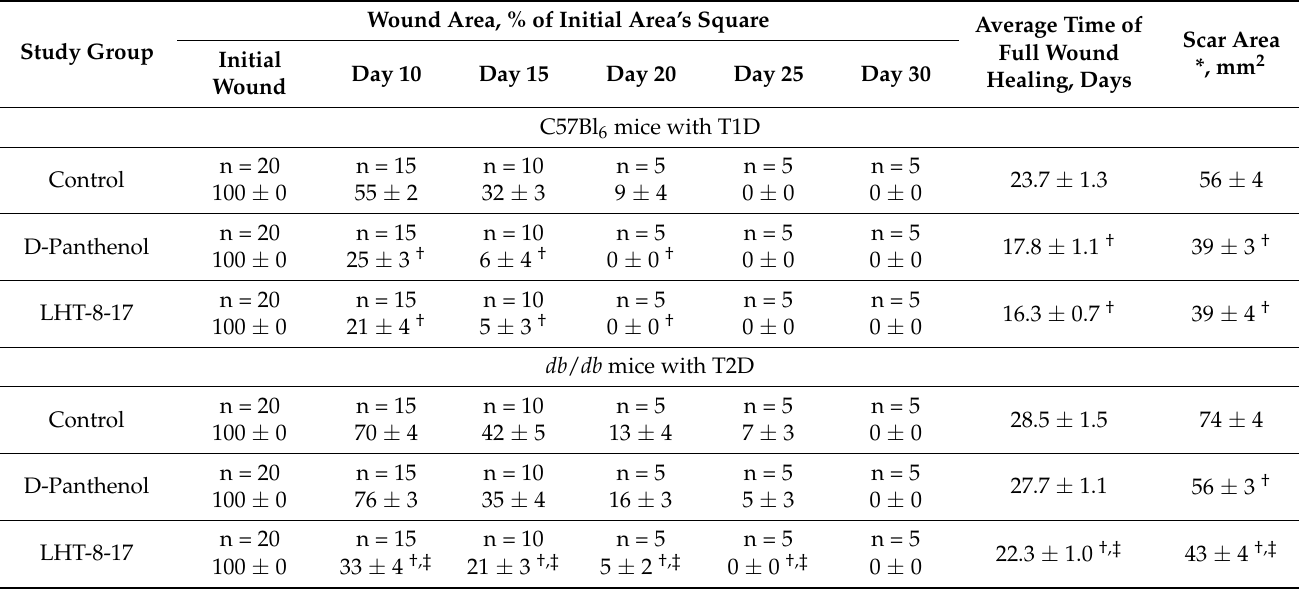
Table 1. The dynamics of non-infected wound areas (% of initial area’s square) in streptozotocin-induced (T1D) and db/db (T2D) mice, topically treated with 4 mg LHT-8-17 and 4 mg D-panthenol as a spray twice daily, mean ± SD.